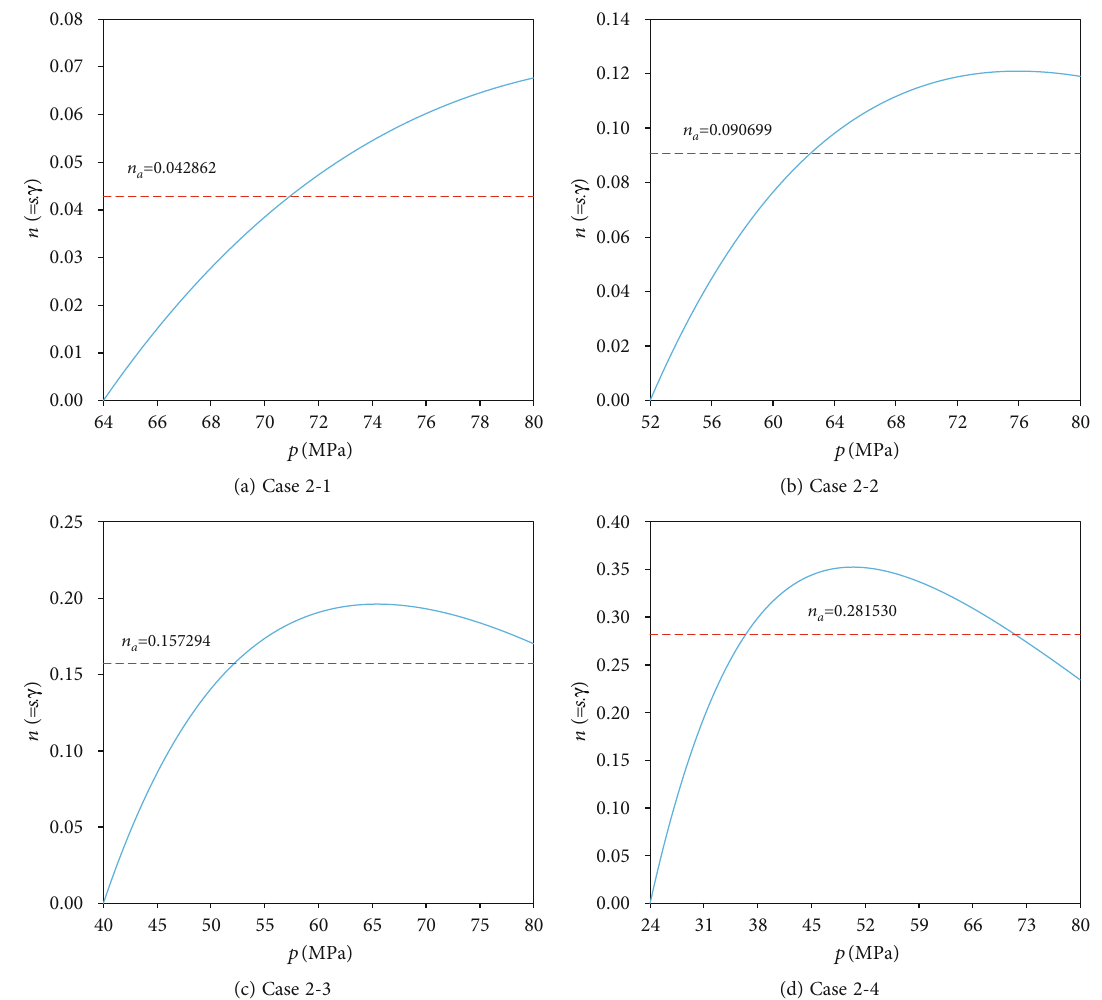
Figure 35: Instantaneous decline exponent n vs. p for the simulated gas reservoir with high